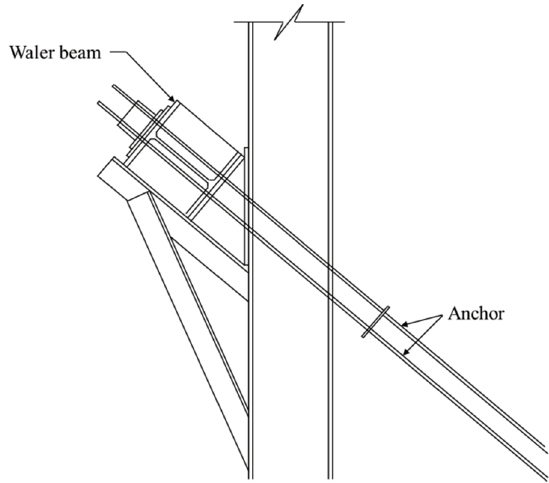
Figure 2. Section A-A of a waler beam supported by ground anchors in a retaining wall